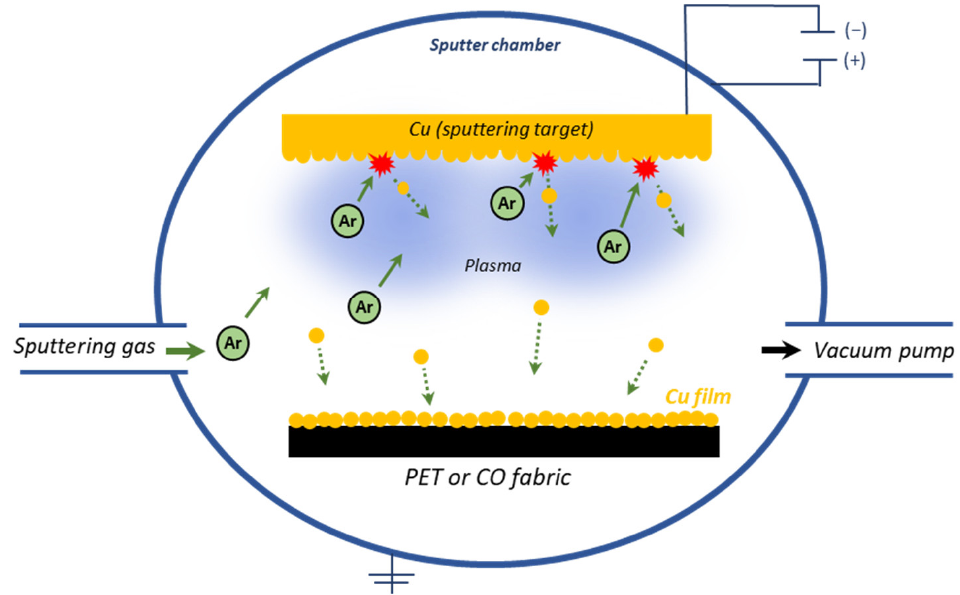
Figure 1. Schematic diagram of DC magnetron sputtering system.